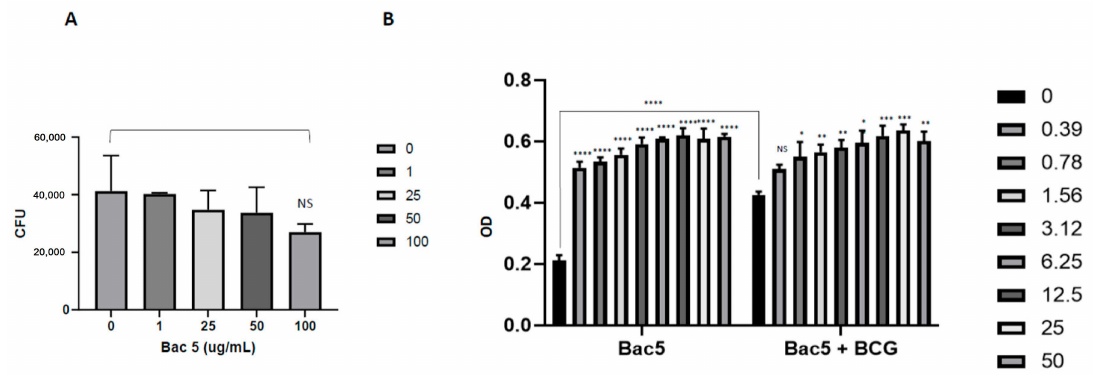
Figure 1. Activation of nitric oxide production from murine alveolar macrophage(MH-S) macrophage-like cells by Bac5 and e ff ect on intracellular-resident MTB. MH-S cells were infected with MTB H37Rv at an MOI of 2 for 4 h in wells containing a titration of Bac5 peptide (0–100 µ g / mL). This was followed by a wash step and addition of amikacin (200 µ g / mL) to kill extracellular mycobacteria for 2 h prior to cell lysis and enumeration of viable bacteria by colony forming unit assay ( A ). Nitric oxide production by MH-S cells induced by Bac5 (0–50 µ g / mL), or Bac5 with M. bovis BCG (MOI of 1) was assessed by Griess assay following 18 h coincubation of cells with stimuli ( B ). Absorbance was recorded at 560 nm using a spectrophotometer and two-way ANOVA performed to determine statistical significance (**** = p < 0.0001, *** = p < 0.001, ** = p < 0.01, * = p < 0.1, NS = No Significance) from triplicate technical